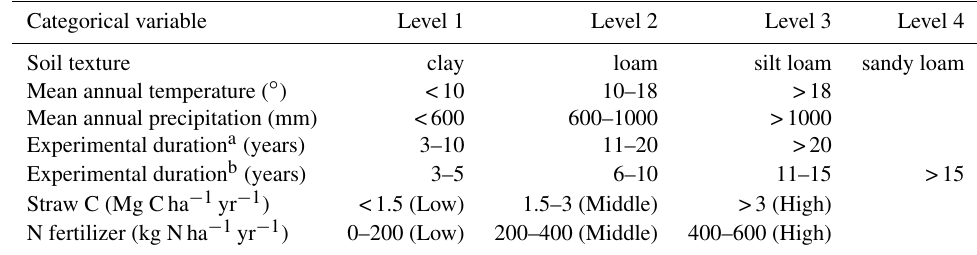
Table 1. Classification of categorical variables used as explanatory factors. Categorical variable Level 1 Level 2 Soil texture